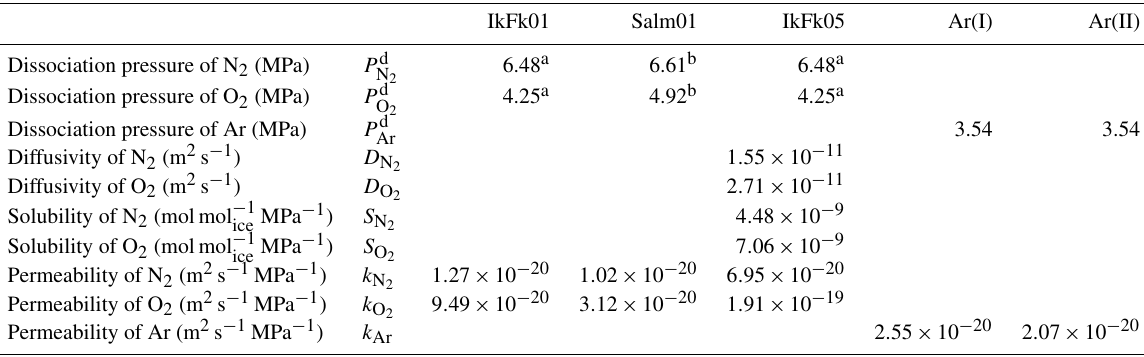
Table A2. Model parameters. Constant of dissociation pressure for N 2 a N Constant of dissociation pressure for O 2 b N Constant of dissociation pressure for N 2 (K) a O Constant of dissociation pressure for O 2 (K) b O Constant of diffusion or permeation for N 2 in ice (m 2 s − 1 ) k 0 Constant of diffusion or permeation for O 2 in ice (m 2 s − 1 ) – Constant of solution for N 2 in ice (molmol − 1 Constant of solution for O 2 in ice (molmol − 1 Constant of diffusion for N 2 in ice (m 2 s − 1 ) D 0 Constant of diffusion for O 2 in ice (m 2 s − 1 ) D 0 Activation energy of permeation for N 2 in ice (kJmol − 1 ) – Activation energy of permeation for O 2 in ice (kJmol − 1 ) – Activation energy of solution for N 2 in ice (kJmol − 1 ) – – 9.2 e Activation energy of solution for O 2 in ice (kJmol − 1 ) E S Activation energy of diffusion for N 2 in ice (kJmol − 1 ) – – 5.1 e Activation energy of diffusion for O 2 in ice (kJmol − 1 ) – –